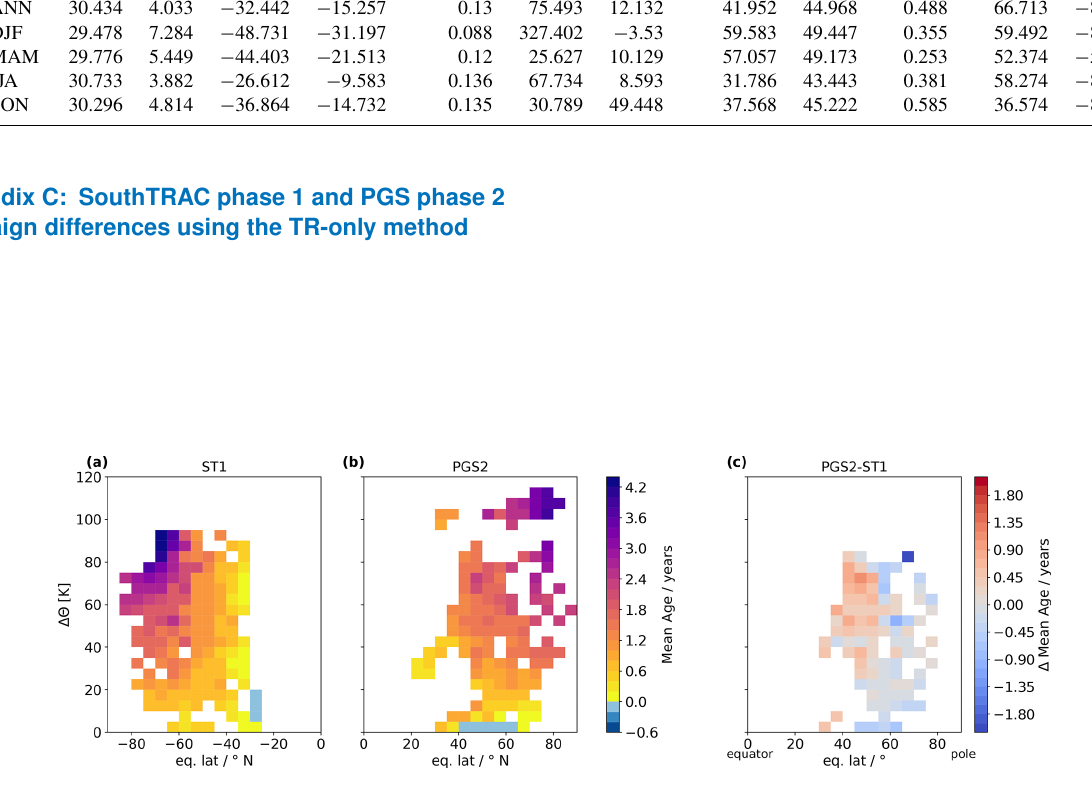
Figure C1. Same as Fig. 4, but mean ages have been derived using the conventional TR-only method instead.